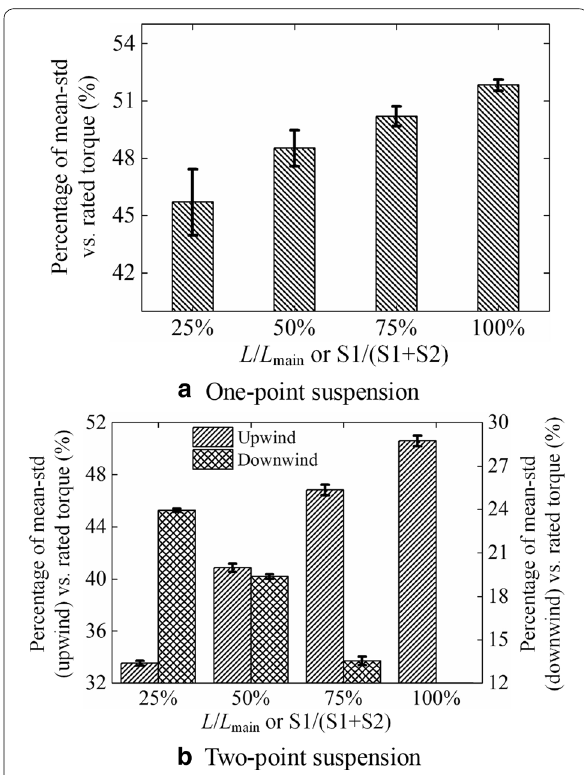
Figure 12 The radial force of main shaft bearing